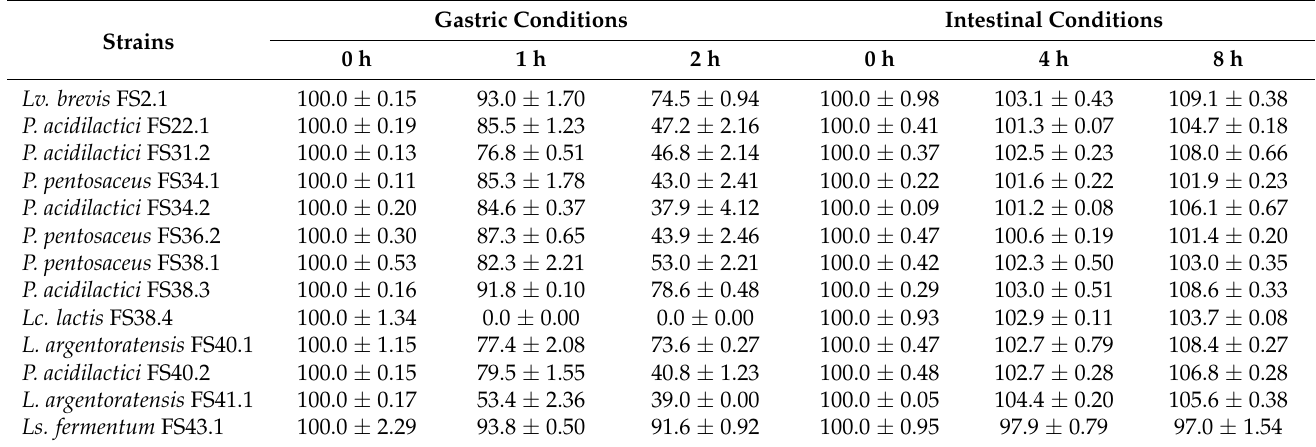
Table 3. Survival of XOSs-fermenting LAB under gastric and intestinal